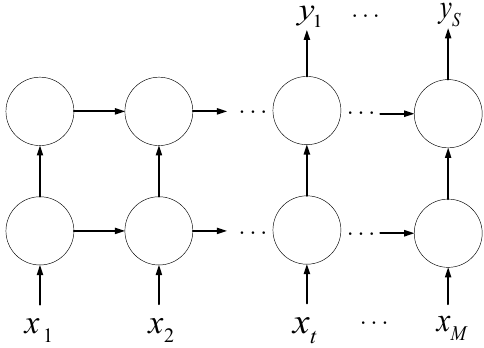
Figure 4. Network structure of the gated recurrent unit (GRU) network